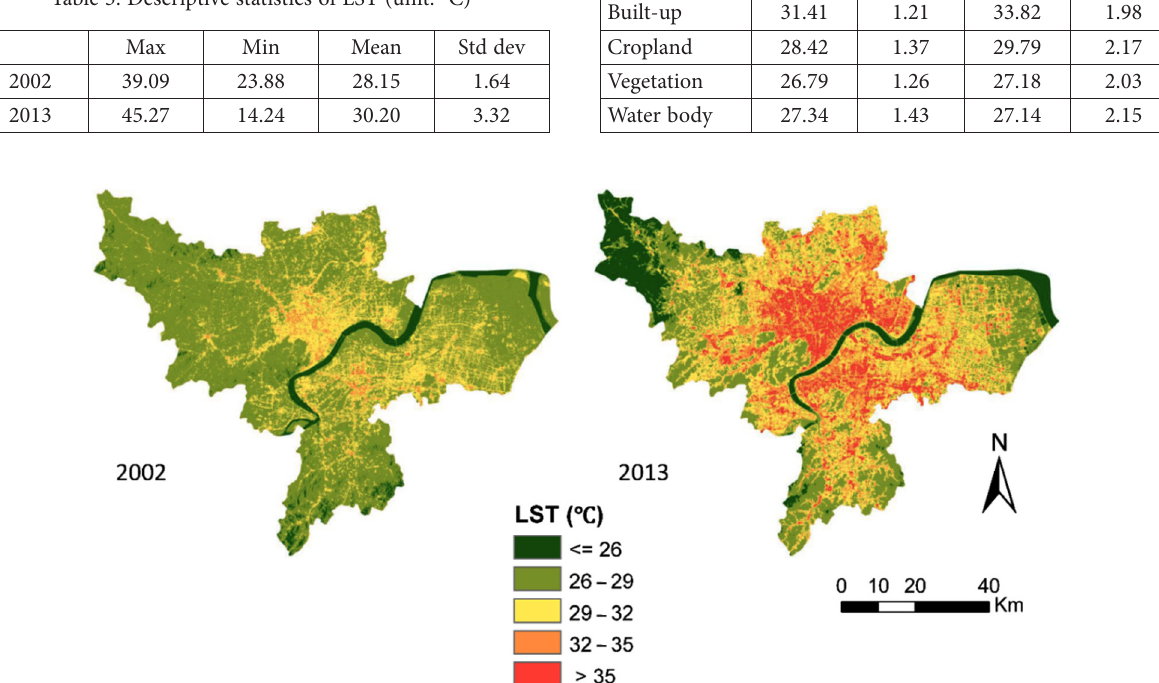
Figure 3. Spatial pattern of LST derived from